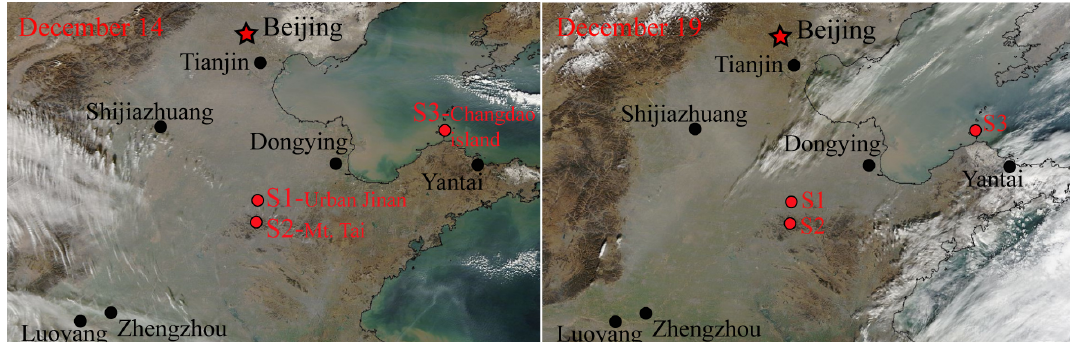
Figure 1. Regional haze layer covering the North China Plain: S1 (urban Jinan), S2 (top of Mt. Tai ), and S3 (Changdao Island) sites. The MODIS images on 14 and 19 December show a grey haze layer during the light and moderate regional hazes over the NCP.